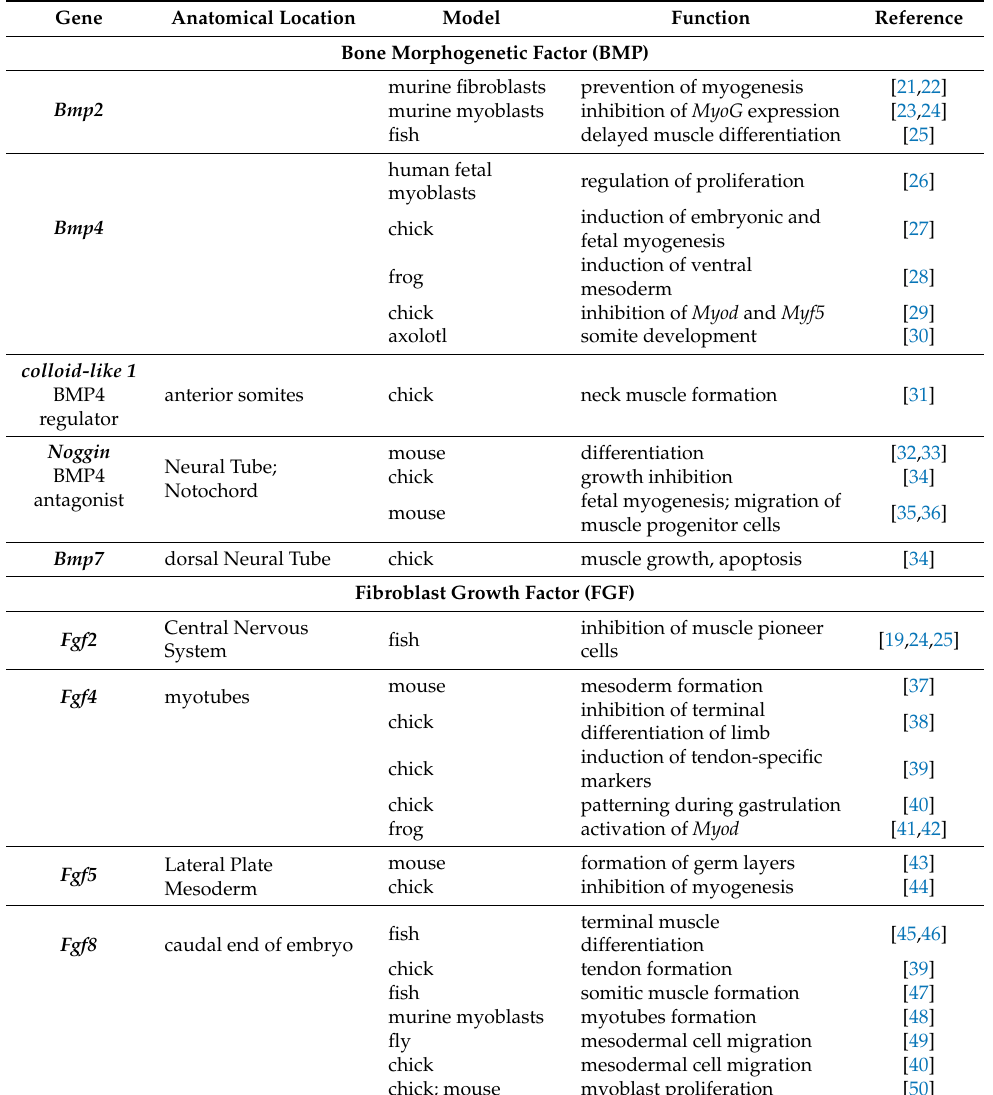
Table 1. Signaling molecules during